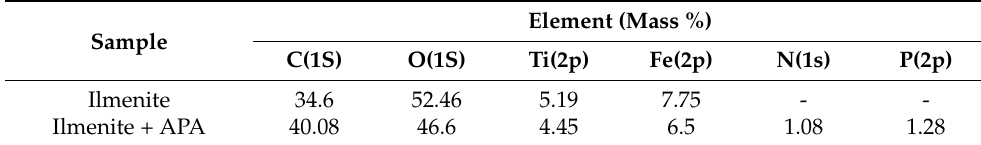
Table 3. Relative amounts of elements on the ilmenite surface.